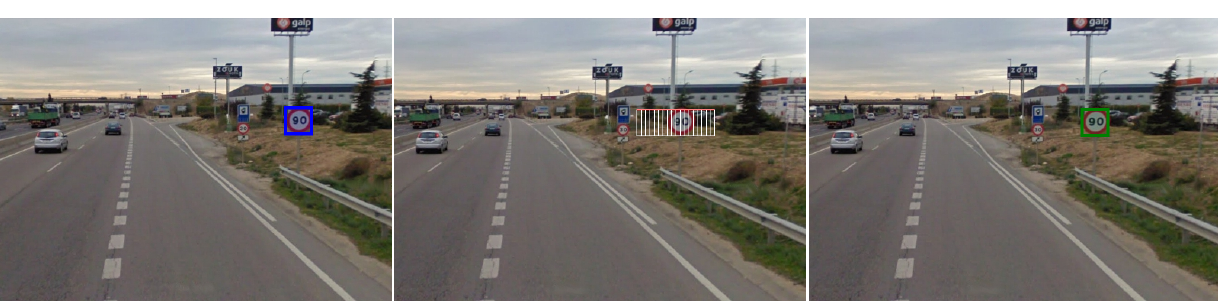
Figure 10. ( Left ) Left image and bounding box of the detected speed sign; ( Middle ) Search space along the epipolar line corresponding to the upper-left part of the bounding box on right image; ( Right ) Final match on right image.